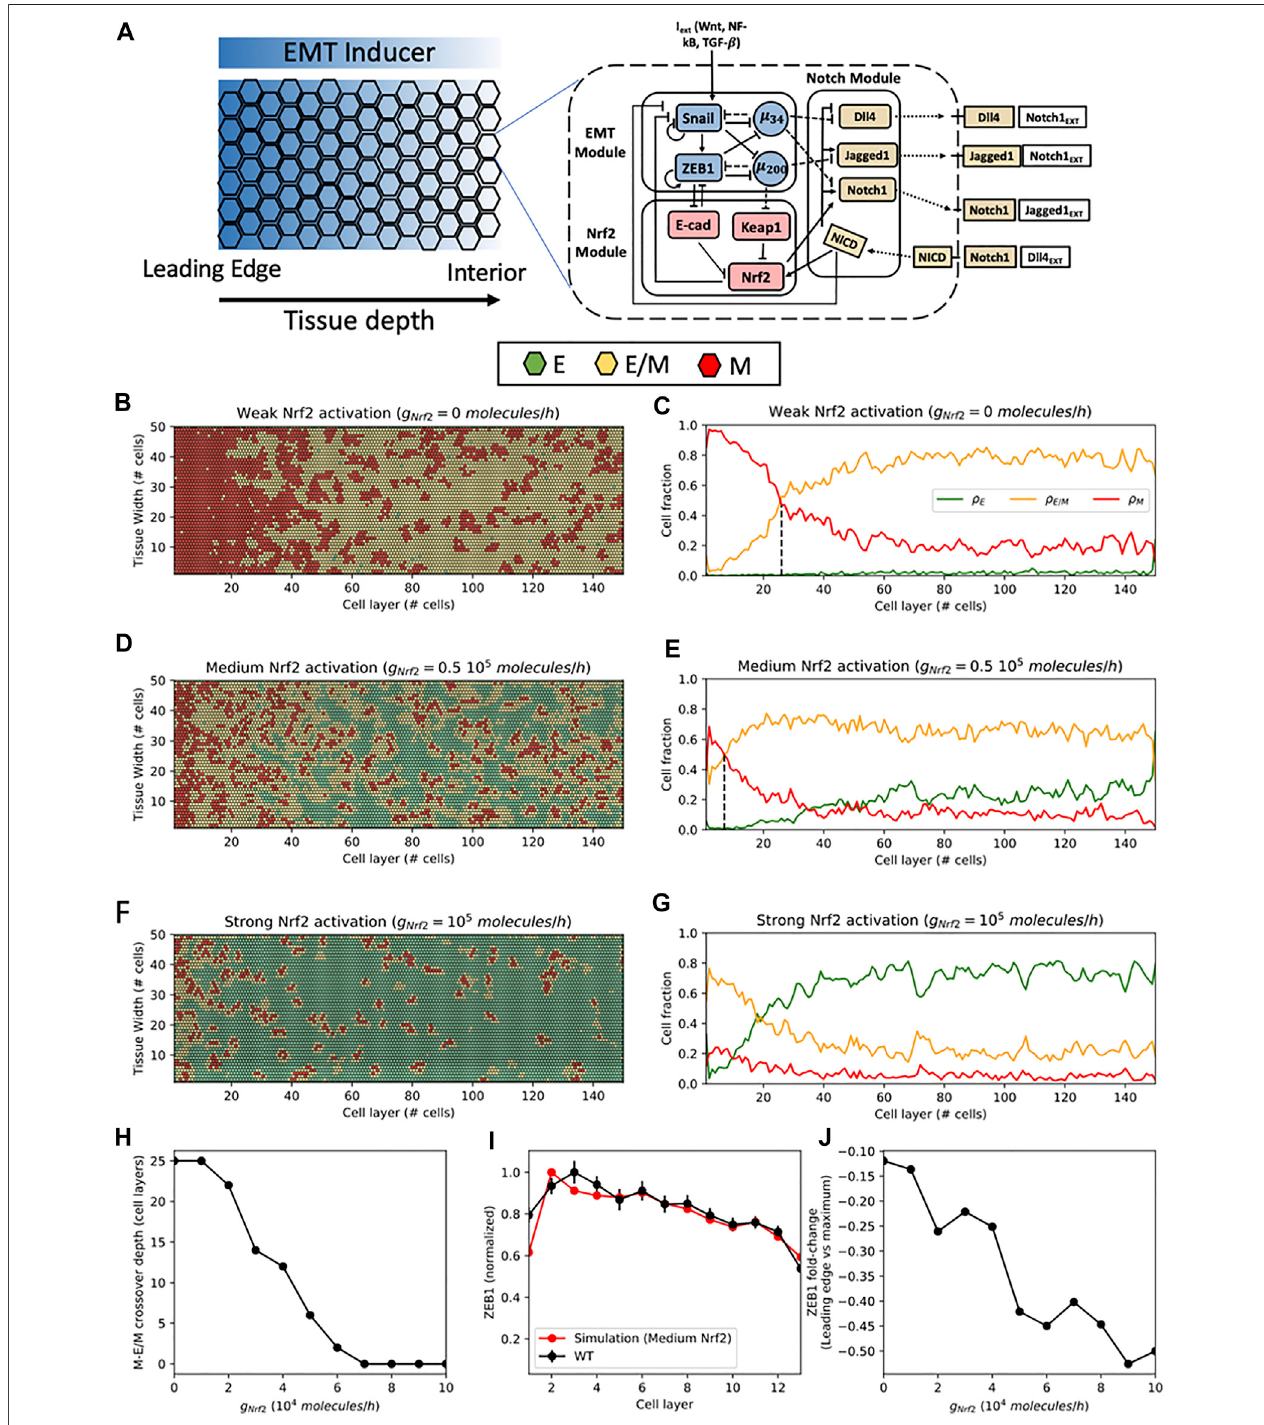
FIGURE 2 | Spatial patterning of cells in the multicell model of cell migration. (A) Left: In the multicell model, cells are arranged on a hexagonal lattice. Cells at the leftmost region (leading edge) are highly exposed toan external EMT-inducing signal (indicated bythe blue shading), while cellsin the interior are weakly exposed. Right: The signaling dynamics within each cell is described by the coupled biochemical network of Nrf2, EMT and Notch. Binding between Notch ligands and receptors of neighboring cells giverise tocell-cell communication. (B) Snapshot ofthemulticell pattern after 120 hofsimulationstartingfrom arandomized initial conditionfor a case of weak Nrf2 activation ( g NRF 2 (cid:1) 0 molecules/hour). Green, yellow and red hexagons depict epithelial (E), hybrid E/M and mesenchymal (M) cells, respectively. (C) Fraction of E, E/M, and M cells as a function of distance from the leading edge for weak Nrf2 activation. Black dashed line indicates the M-E/M crossover point. (D ,